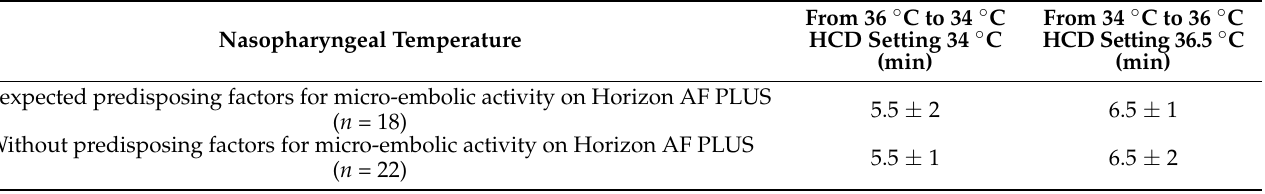
Table 7. Thermal exchange performance for mild hypothermia during CPBs with Horizon AF